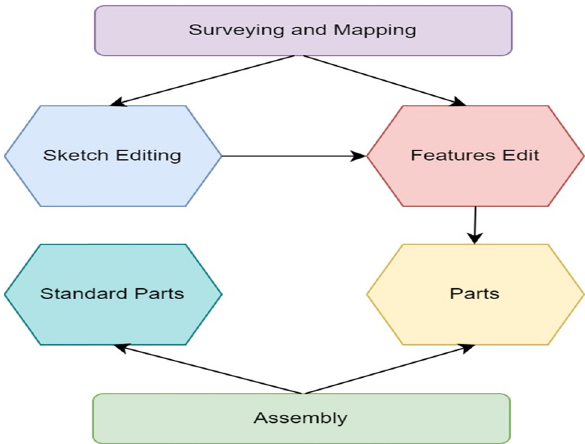
Figure 7: SolidWorks modeling fl